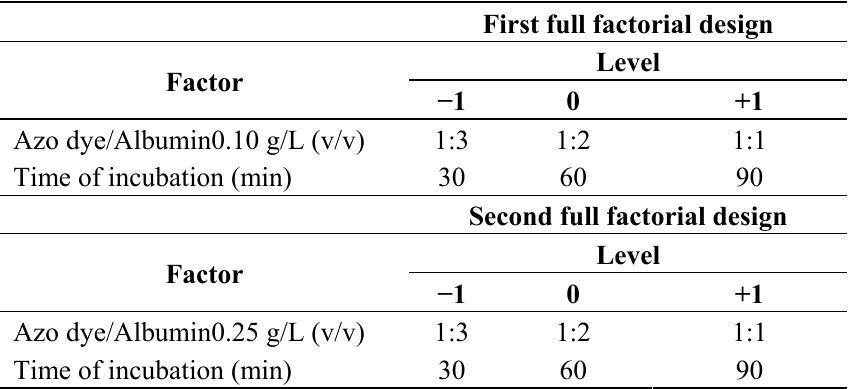
Table 4. Levels of 2 2 full factorial